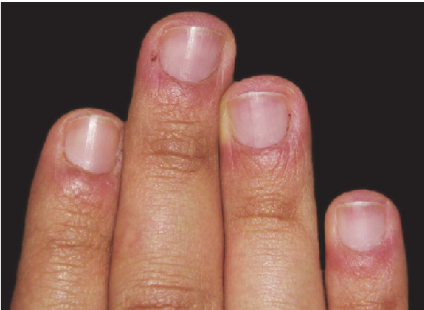
Figure 10: 9 months after the removal of the appliance, the patient has quit the oral habit with persistence of normal appearance of his fingertips